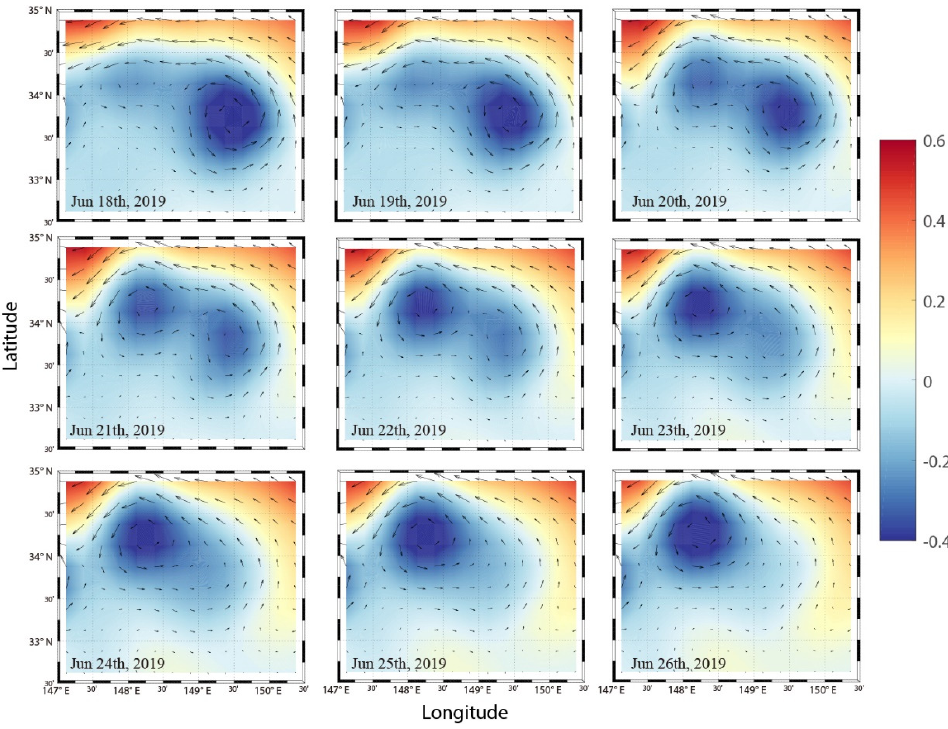
Figure 2. AVISO sea level anomalies and geostrophic velocities from 18 to 26 June 2019.